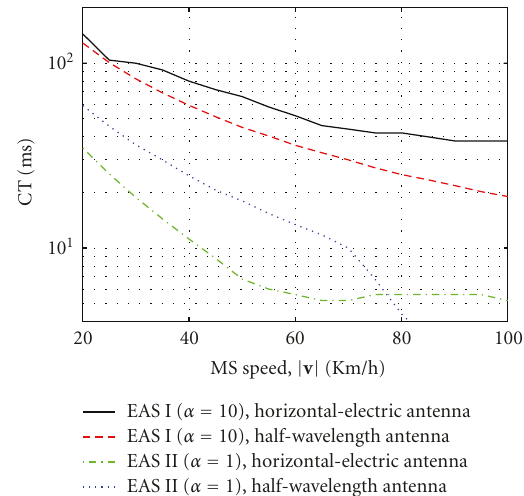
Figure 8: Spatial coherence , with respect to separation between two multicarrier frequencies Δ f , considering EAS I ( α = 10), Laplacian AAS pdf ( a = 0 . 25 rad), using exponential DP with τ = 3 . 33 microseconds, σ = 2microseconds, f 1 = 1GHz, f 2 = f 1 + Δ f , and for a MIMO communication system at the transmitter station (BS) when one antenna is located at the center of the azimuthal plane and the other is located on the x -axis with the separation distance Δ x ; employing half-wavelength dipole or horizontal-electric dipole with the length of h = c/ 2 f